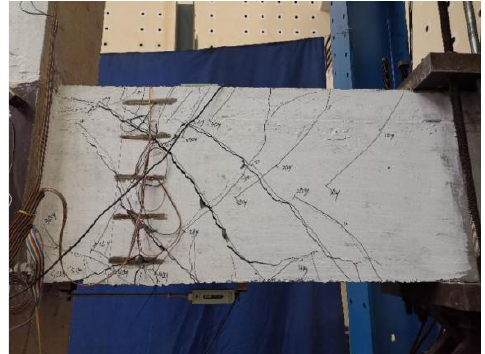
Figure 10. Test phenomenon of specimen J-2.